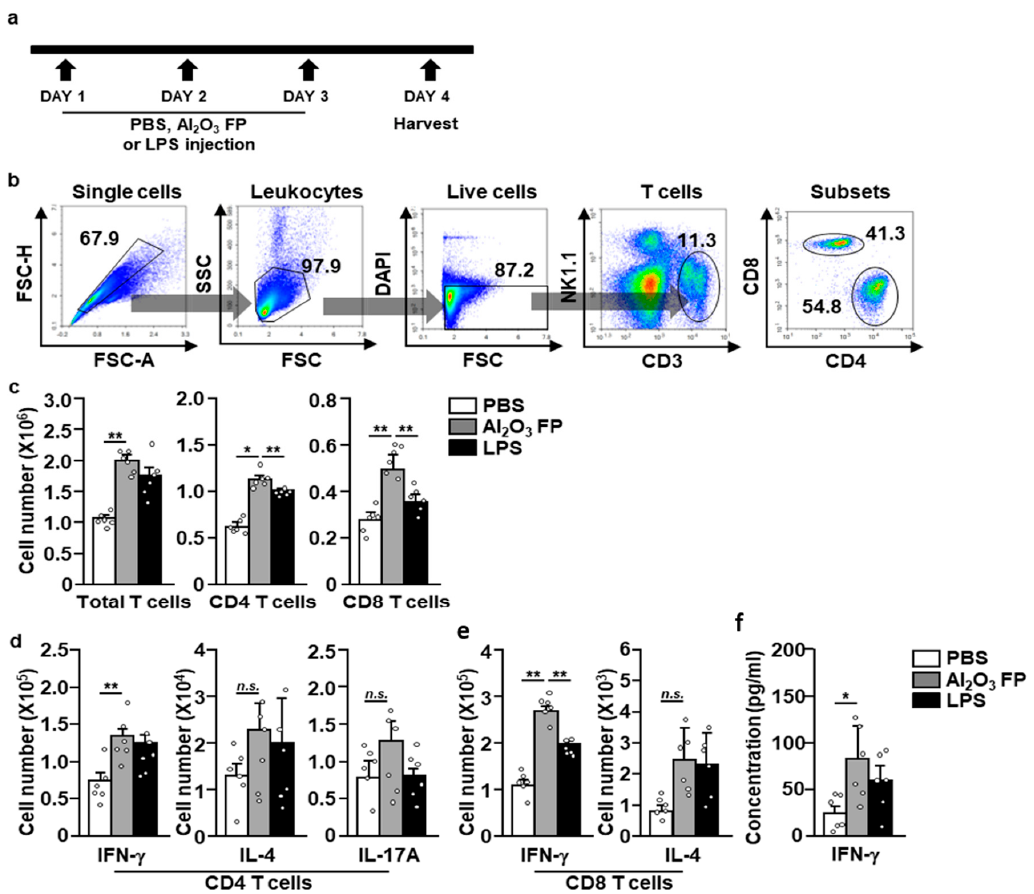
Figure 4. The treatment with Al 2 O 3 FPs promoted the activation of T cells. The C57BL/6 mice were treated with 10 mg/kg of Al 2 O 3 FPs for 3 days. On day 4, the mice were sacrificed, and their spleens were harvested. ( a ) Schematic diagram of T cell activation experiment. ( b ) Definition of spleen T cells. ( c ) The number of total T cells, CD4 T cells, and CD8 T cells in the spleen. The number of intracellular cytokine producing CD4 T cells and CD8 T cells in the spleen ( d and e ). ( f ) The serum concentration of interferon-gamma (IFN- γ ) analyzed by ELISA. All data are representatives and averages of six independent samples (2 mice for three experiments, two-way ANOVA, mean ± SEM). * and ** represent p < 0.05 and p < 0.01, respectively.